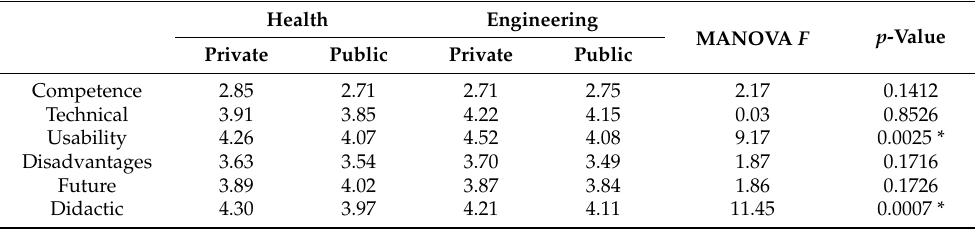
Table 6. Mean ratings and statistics of the MANOVA test distinguishing by area of knowledge and by university